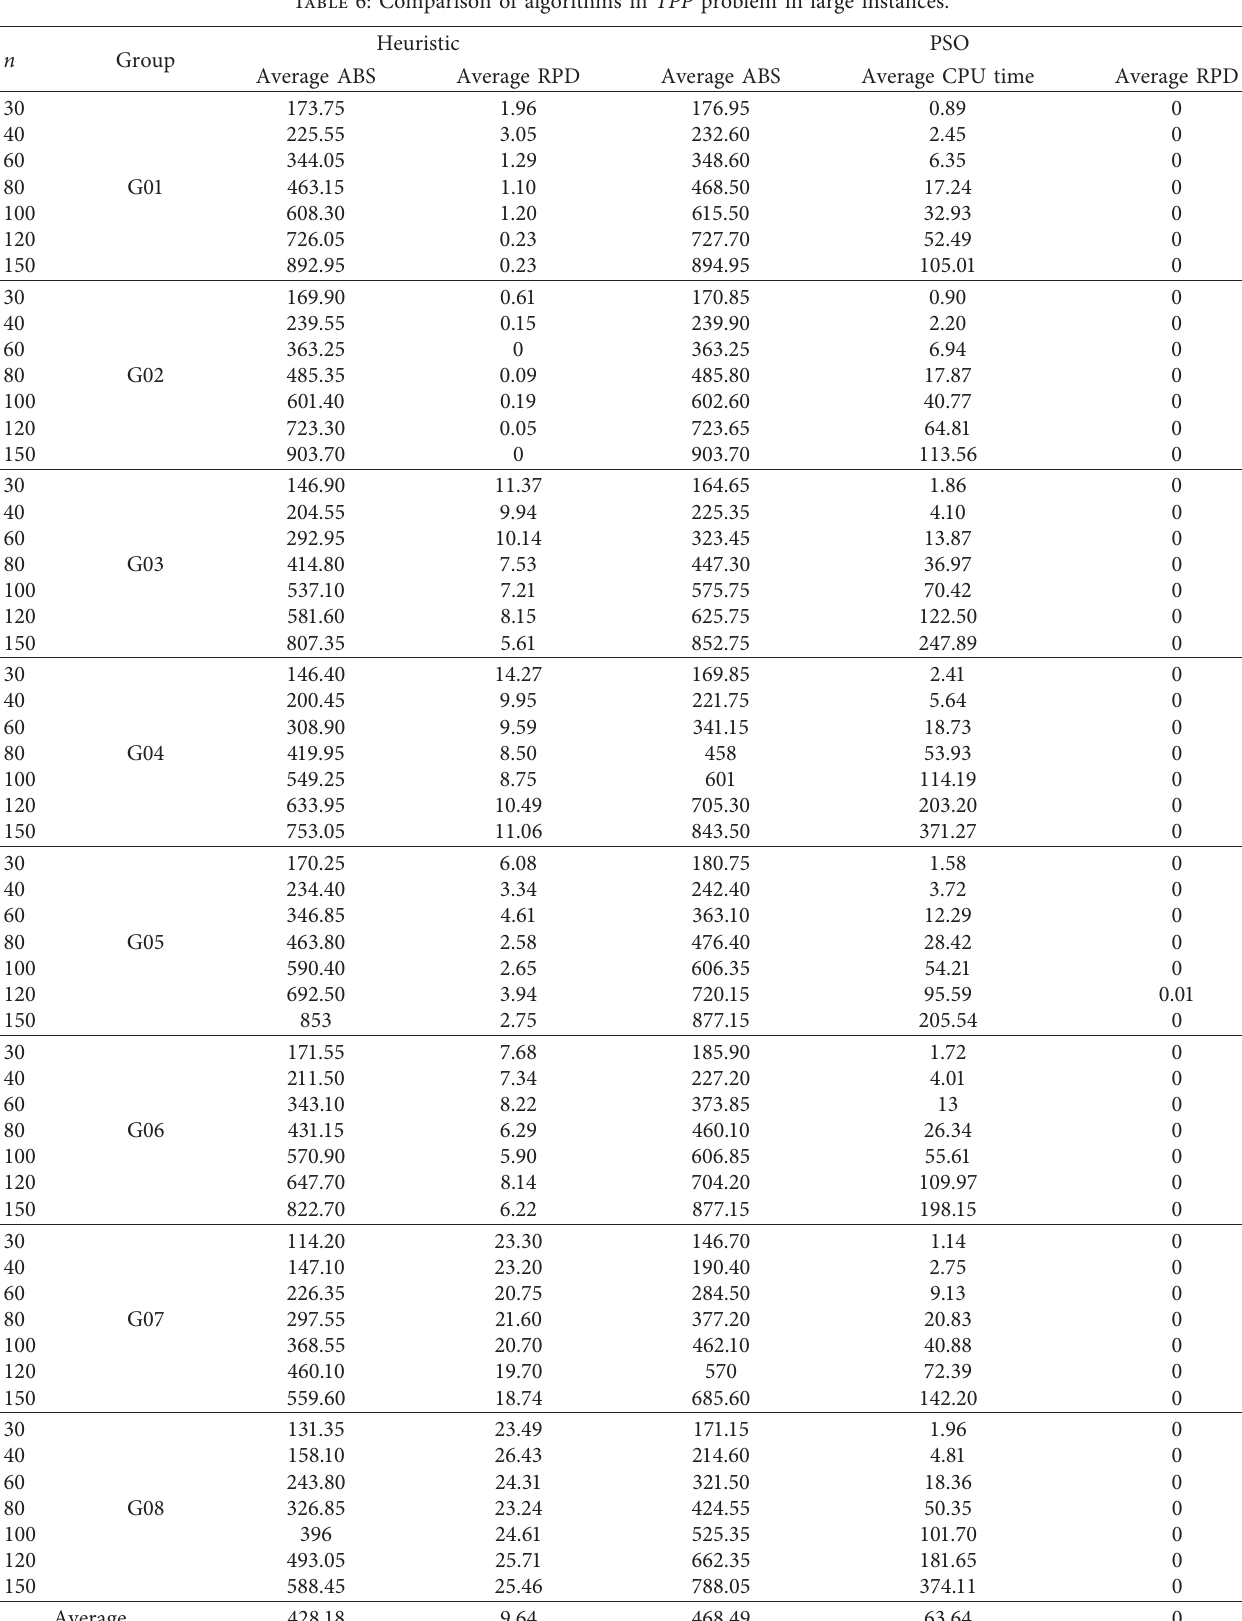
Table 6: Comparison of algorithms in TPP problem in large